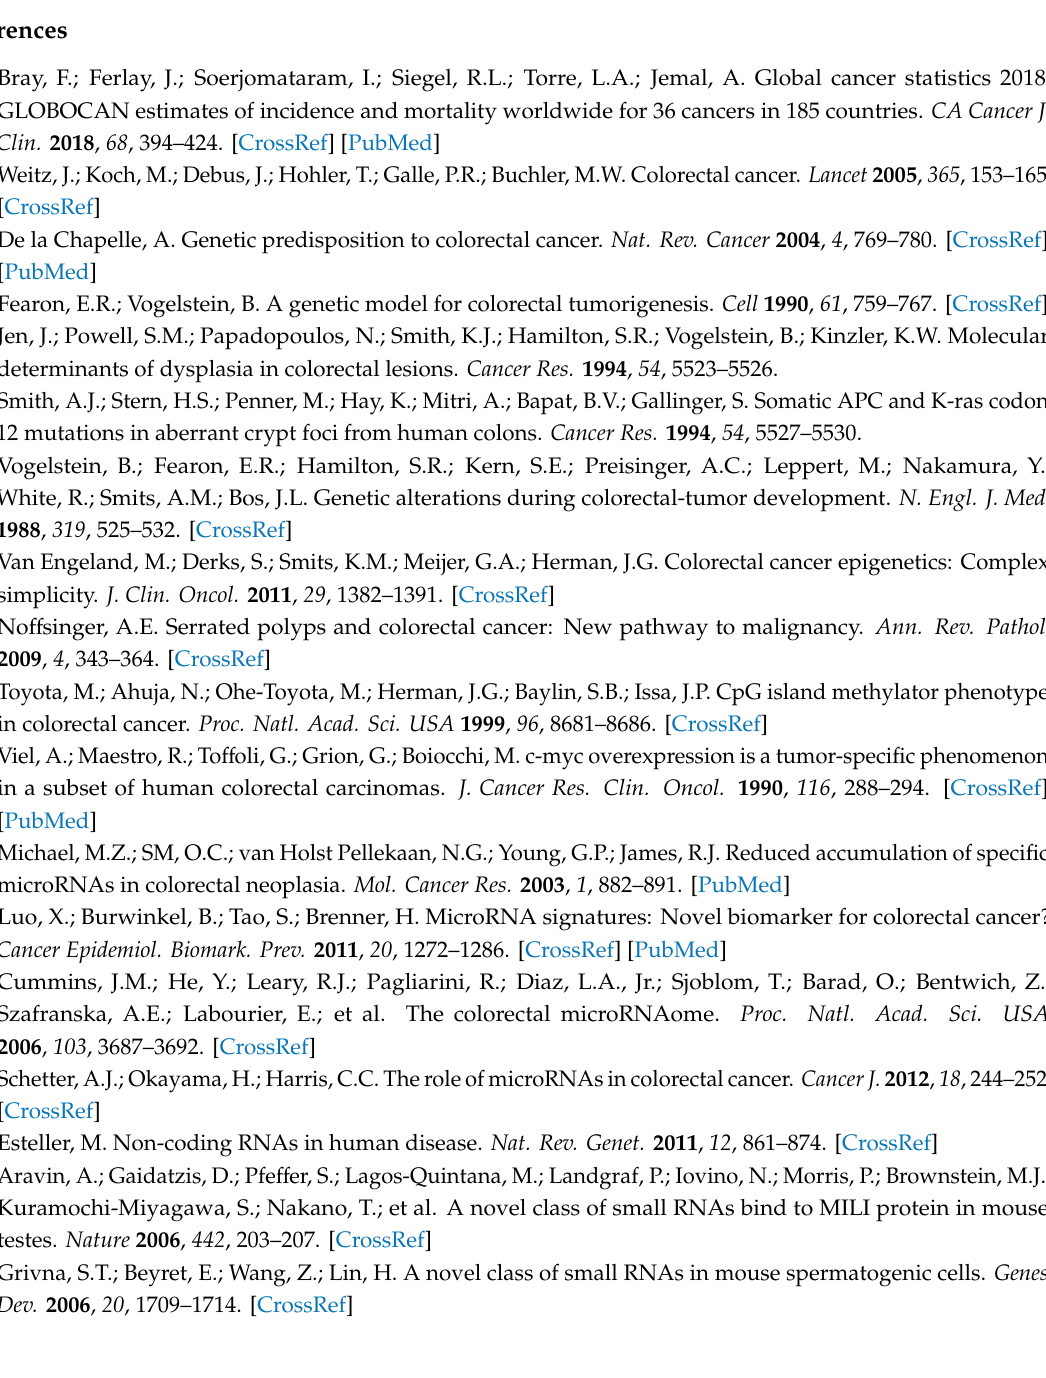
Table S1a. Significantly expressed upregulated (fold change ≥ 2) piRNAs in CRC ( n = 32); Table S1b. Significantly expressed downregulated (fold change ≤ 2) piRNAs in CRC ( n = 111); Table S2. Primer sequences used for reverse transcription (RT) and quantitative polymerase chain reaction